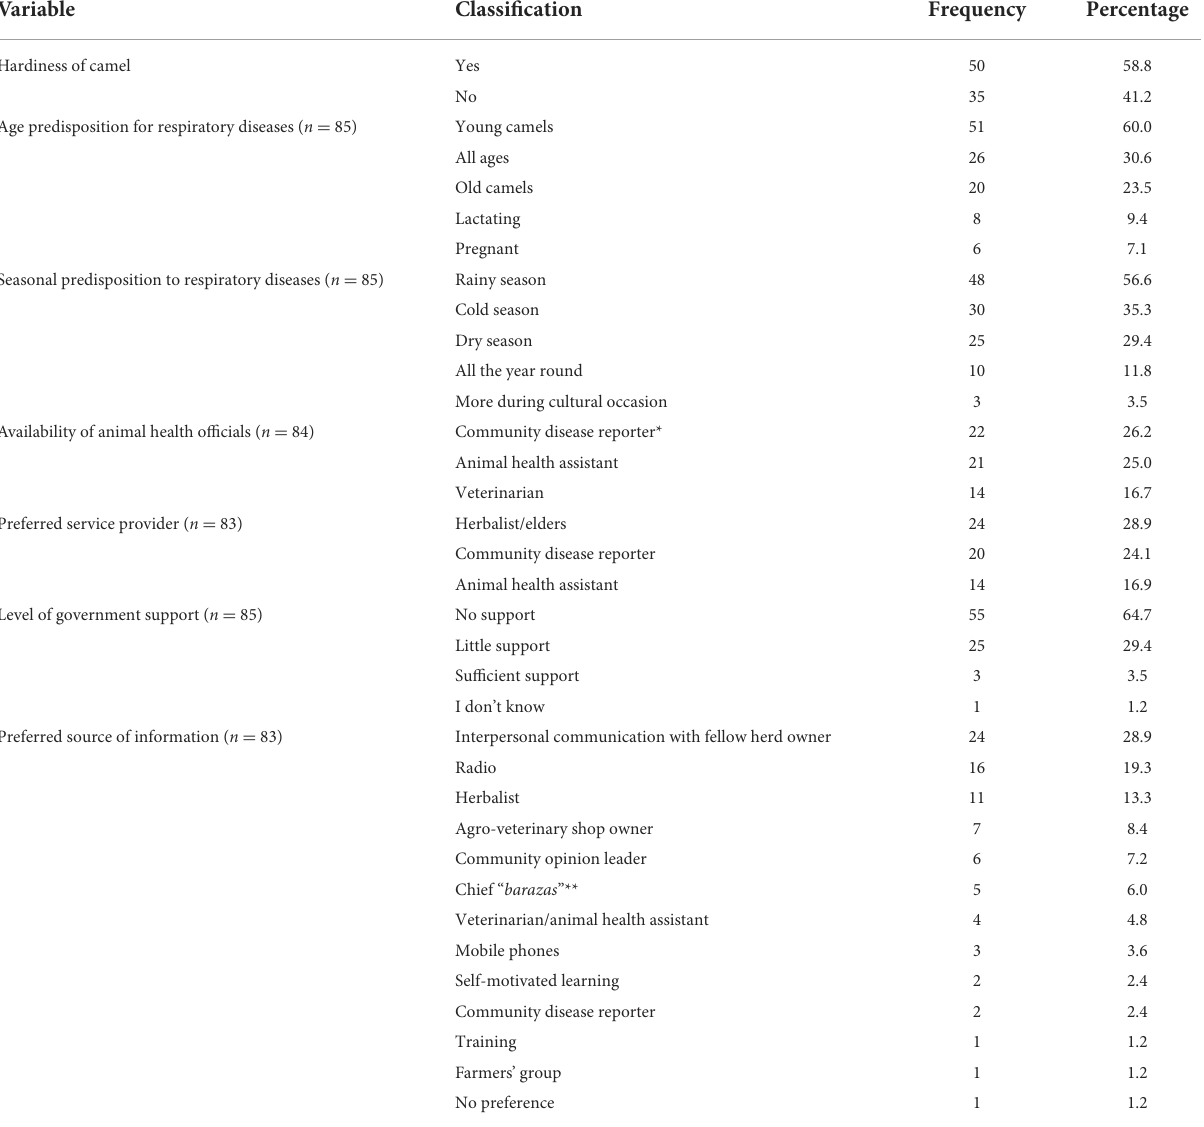
TABLE 5 Attitudes and disposition to camel diseases and information